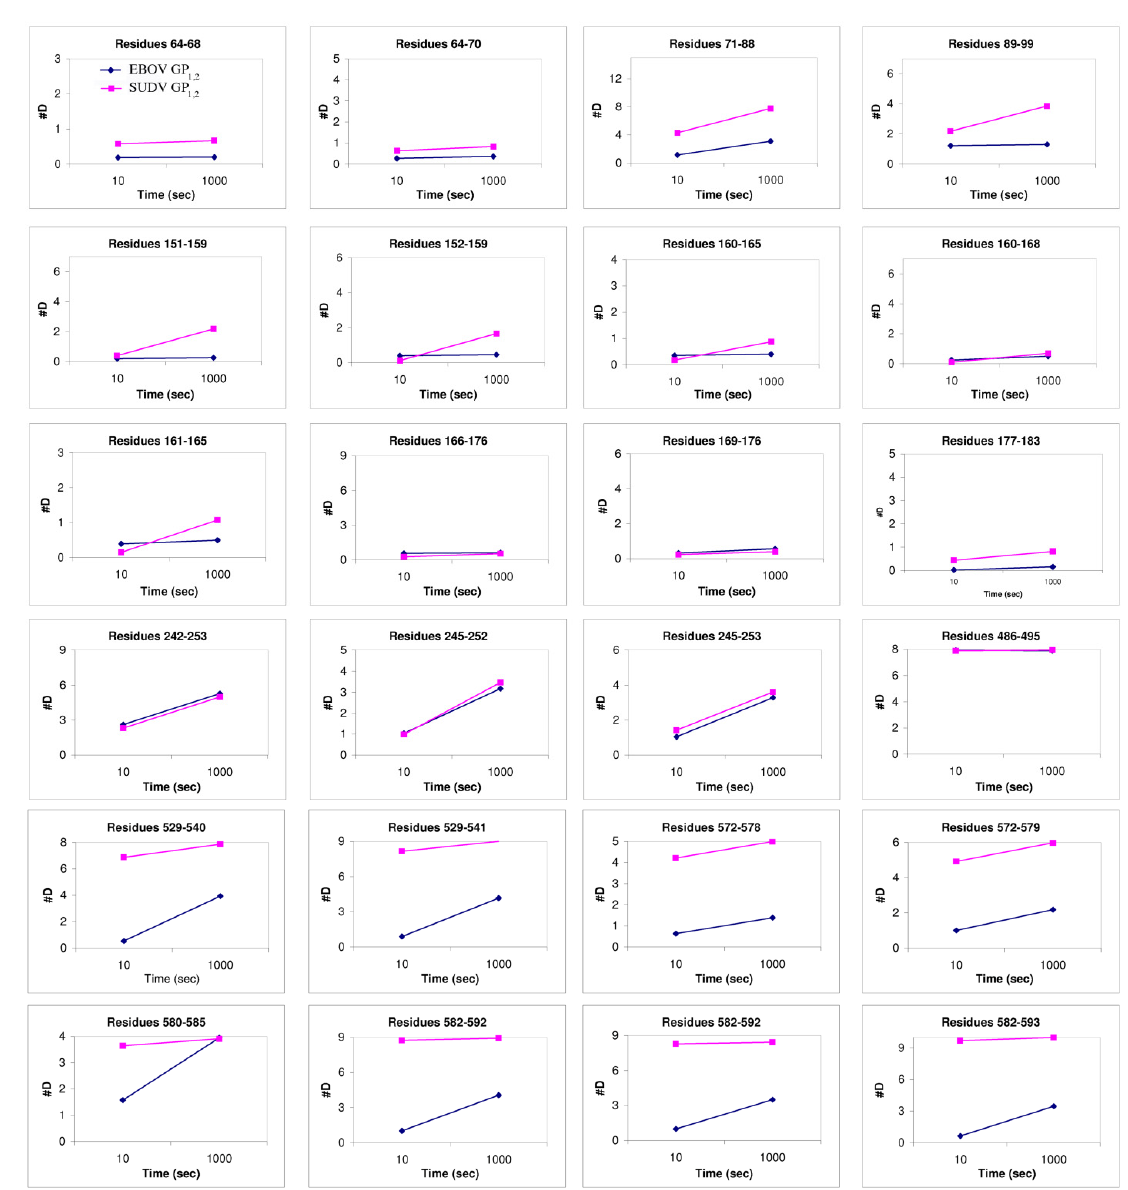
Figure 6. Plots of number of deuterons vs . time. These compare the deuteration levels of key (shown in blue) to their counterparts in SUDV-Gul GP peptides of EBOV GP 1,2 magenta), measured over a time scale of 10-1000 sec using deuterium exchange mass spectrometry